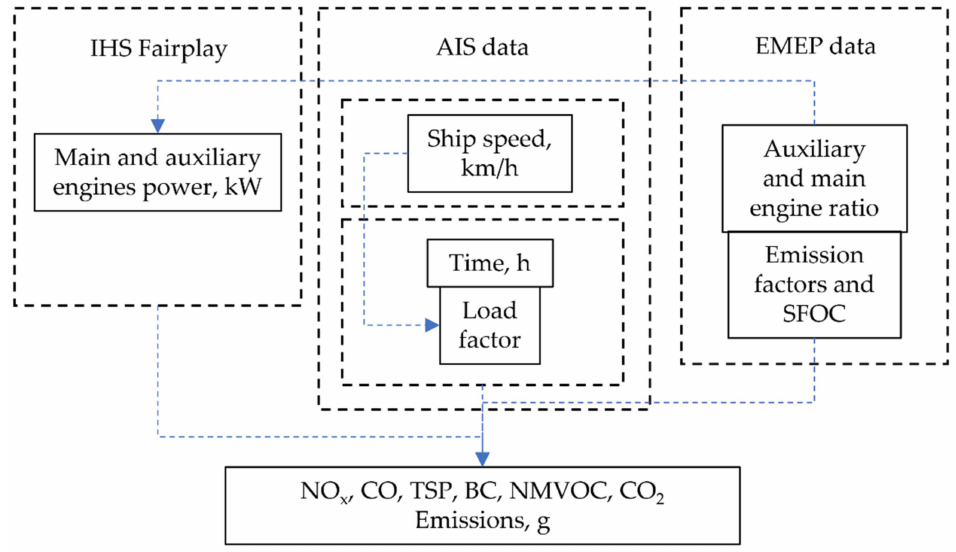
Figure 2. Algorithm for the calculation of